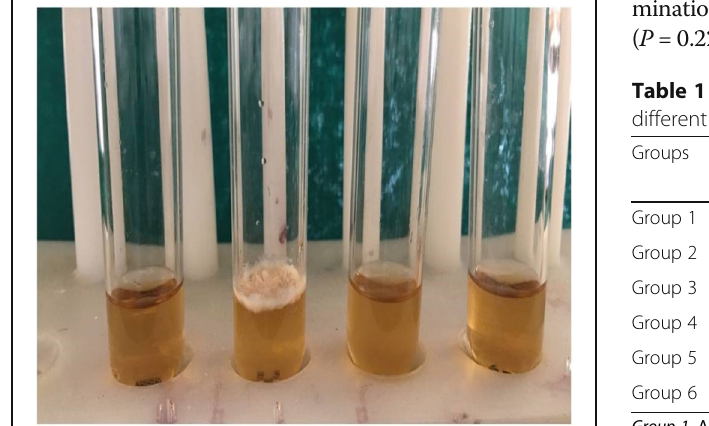
Fig. 2 One of the brackets (2nd tube from the left) showing microbial growth in the brain heart infusion broth